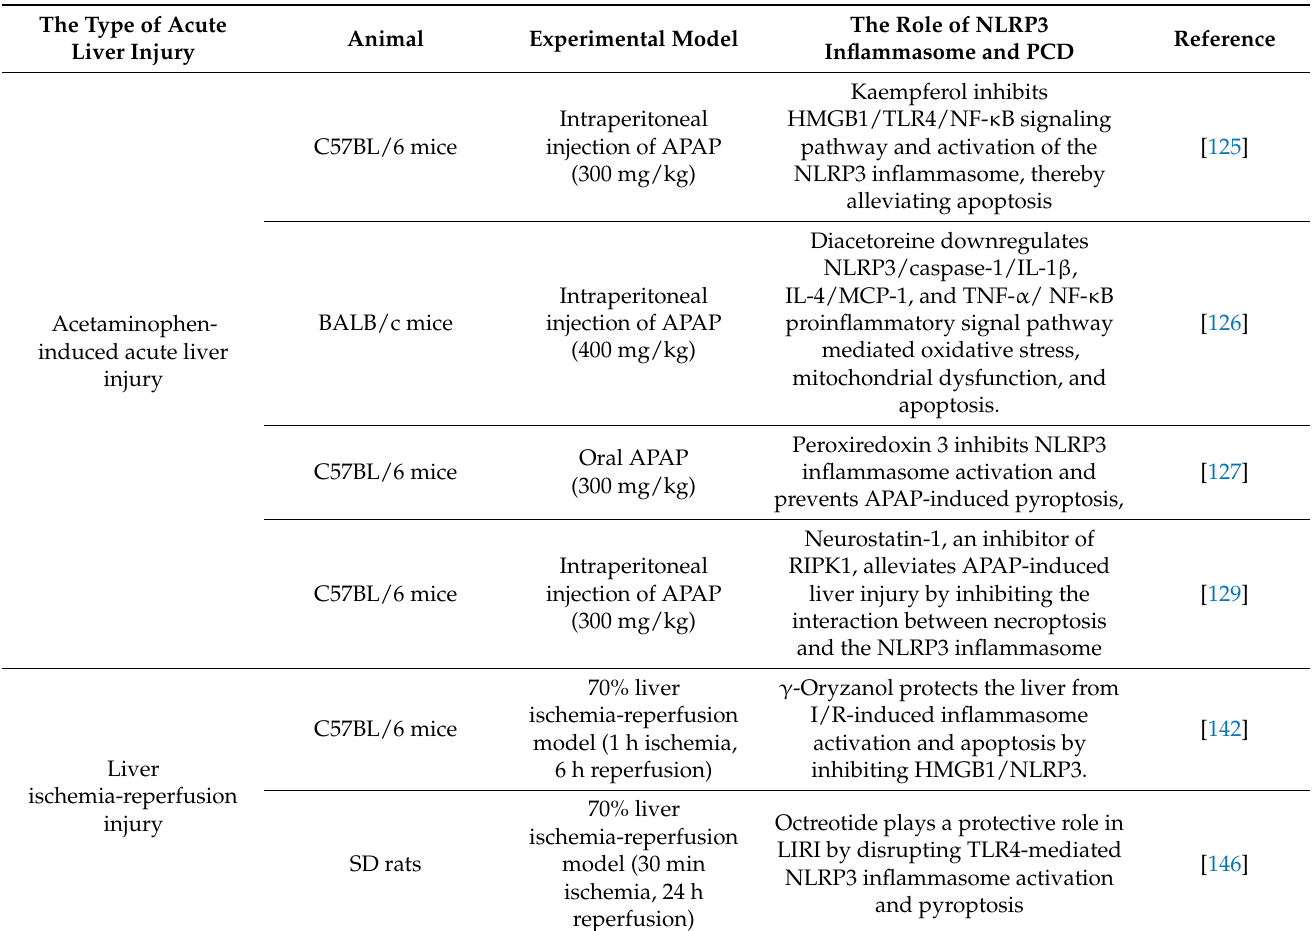
Table 1. Summary of the roles of NLRP3 inflammasome and programmed cell death in ALI animal